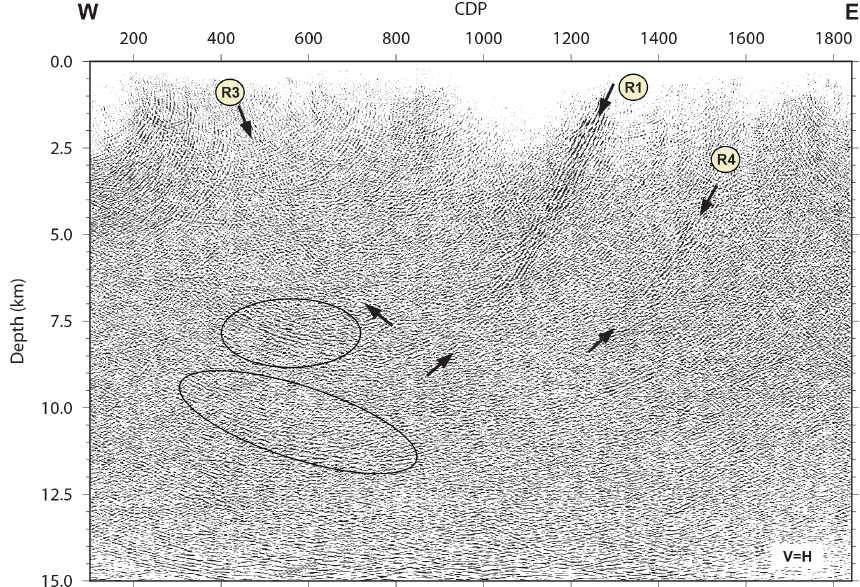
Figure 6. The migrated section. The reflections (shown by the arrows) were migrated to their true locations using the velocity model provided by Lindblom et al. (2015).